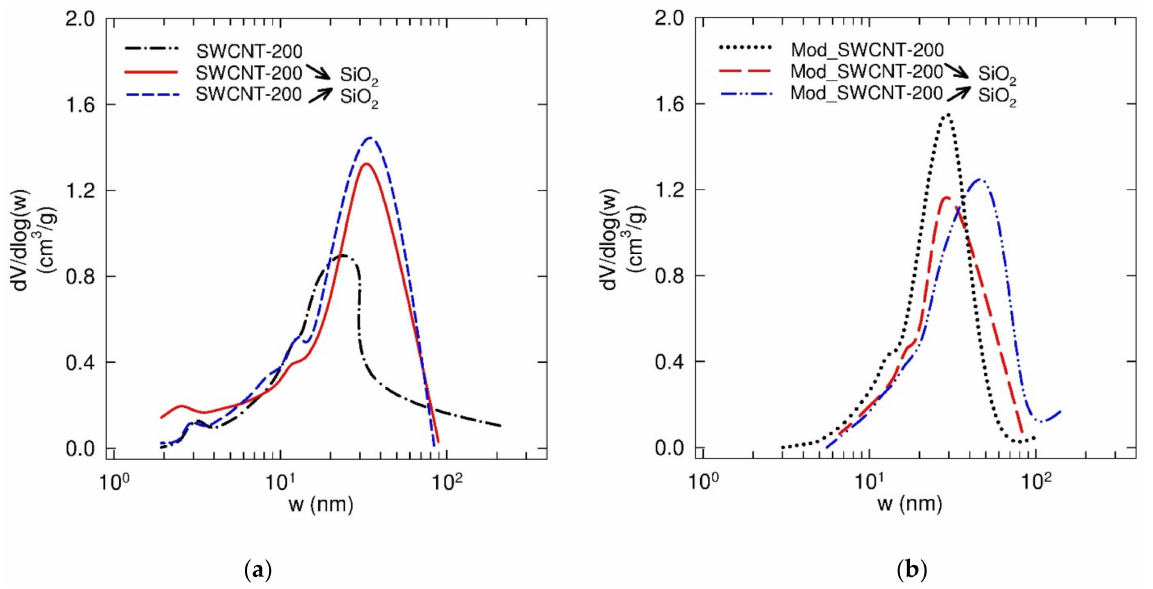
Figure 7. Pore size distribution evaluated from the desorption branch of the nitrogen sorption isotherm at 77 K: for unmodified ( a ) and modified ( b ) membranes by a hydrophobic layer.